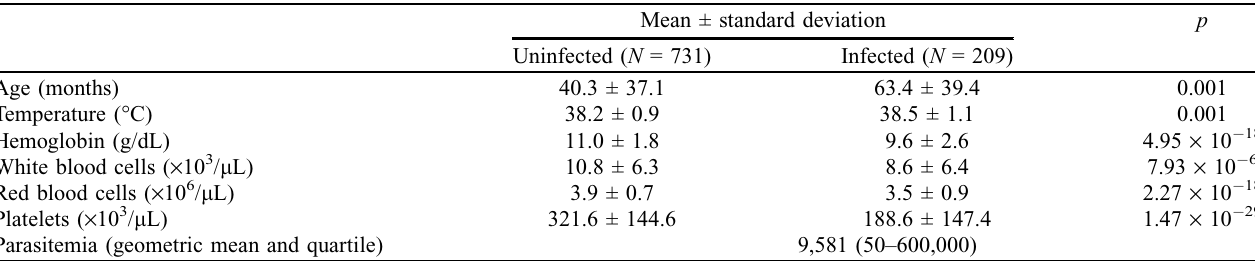
Table 3. Comparison of characteristics between Plasmodium uninfected versus infected children (diagnosed by RDT and blood smear).